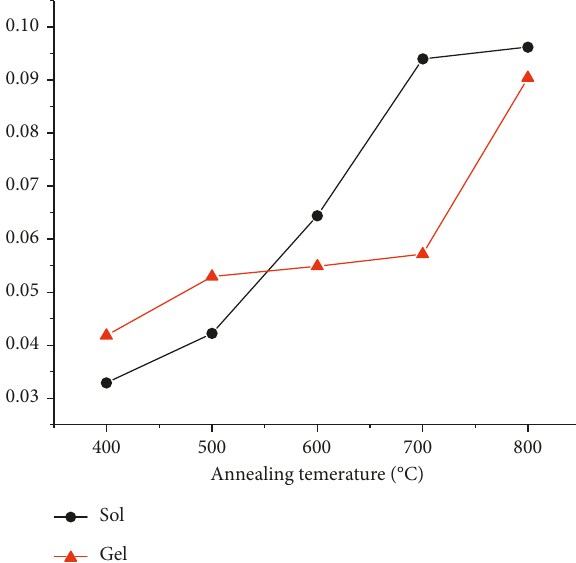
Figure 6: Saturation magnetization and coercive force of the sol and the gel with annealing temperature.